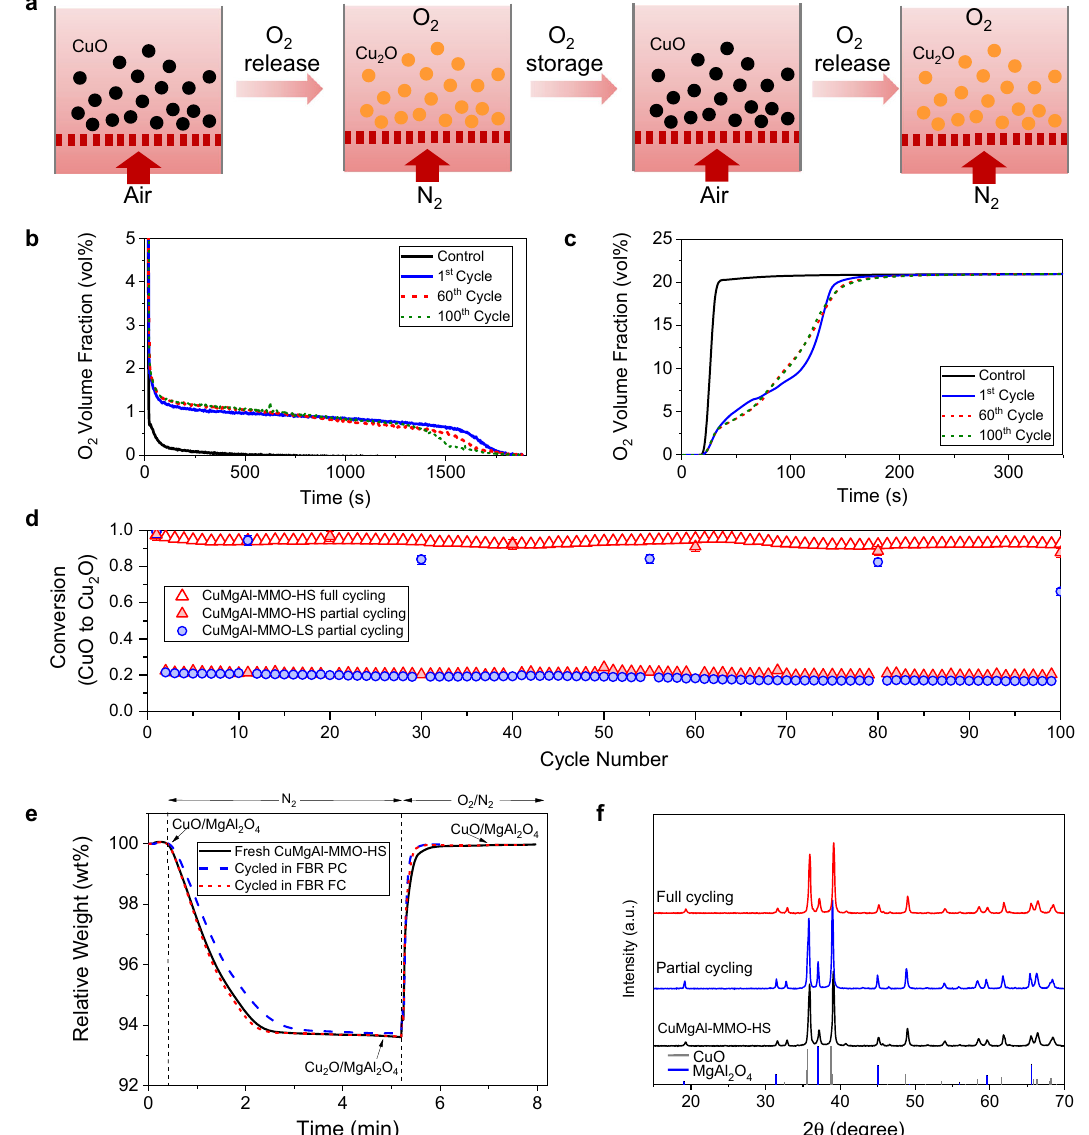
Fig. 6 | Redox cycling of oxygen storage materials in an FBR. Two typical sam- ples were tested: CuMgAl-MMO-LS (low strength), and CuMgAl-MMO-HS (high strength). a Schematic diagram showing the cyclic O 2 release and storage due to phase changes of CuO and Cu 2 O in the MMOs. b O 2 volume fraction of gas during reduction and c oxidation of oxygen storage materials in the FBR. Control experiments were performed with quartz sand loaded in the reactor without the MMO. d ConversionofCuOtoCu 2 Oover100redoxcyclesintheFBR,wherepartial